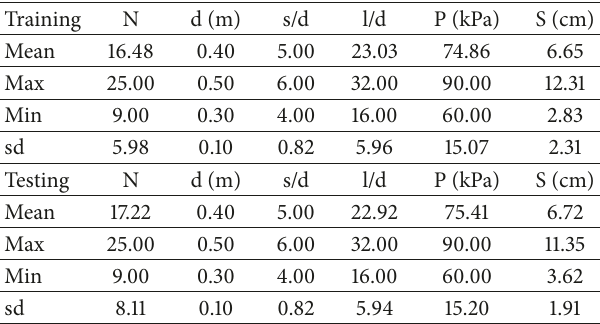
Table 2: Statistical analysis of the training and testing data samples.